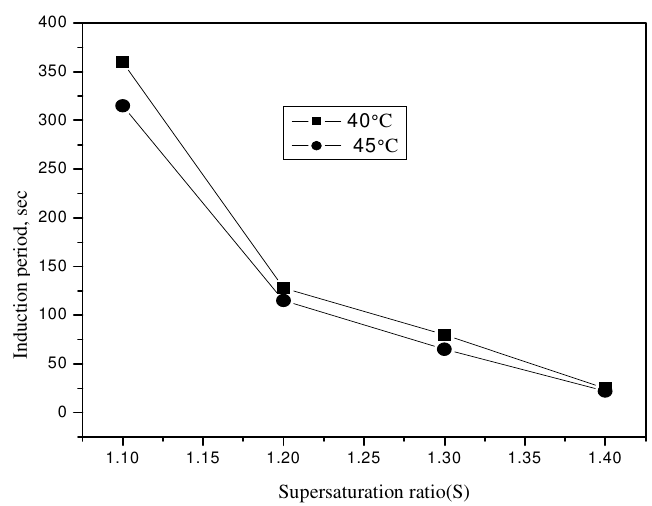
Figure 4. Induction period vs . supersaturation ratio for KFCT solution.